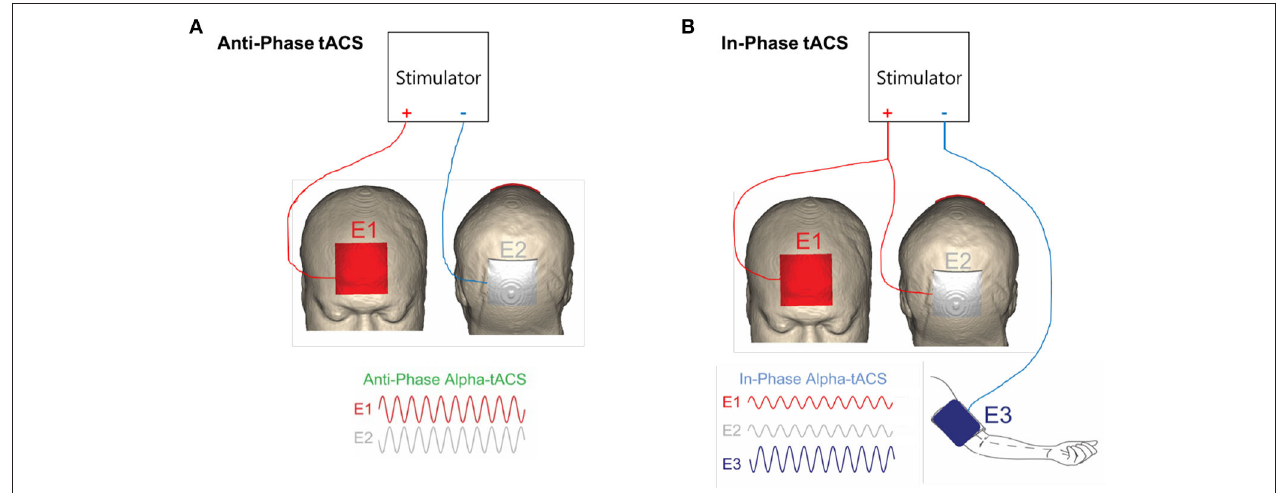
FIGURE 1 | (A) Montage for fronto-parietal anti-phase alpha frequency desynchronizing stimulation. (B) Montage for fronto-parietal in-phase alpha frequency synchronizing stimulation. Adapted from Ahn et al. (19).